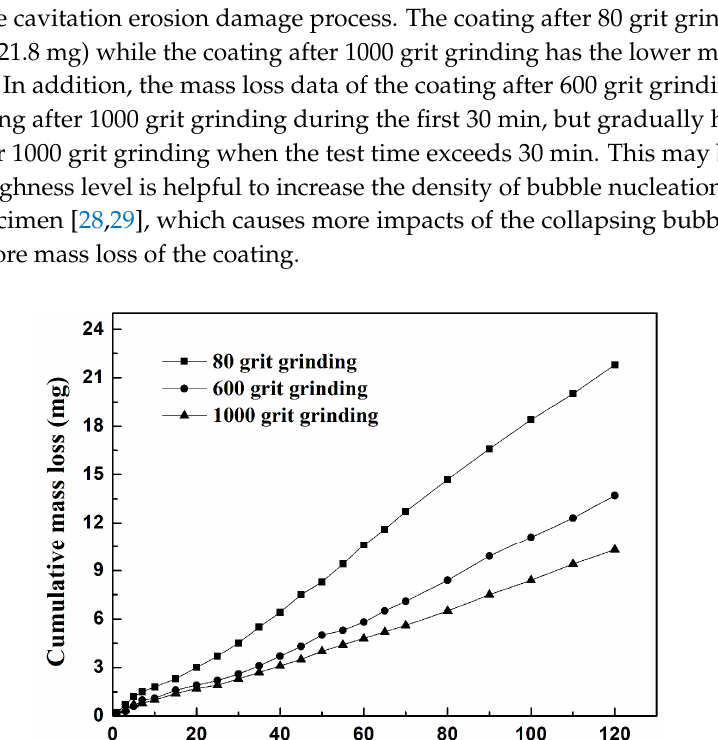
Figure 3. The relationship between cumulative mass loss and cavitation erosion time for the as ‐ sprayed coatings with three surface roughness levels.